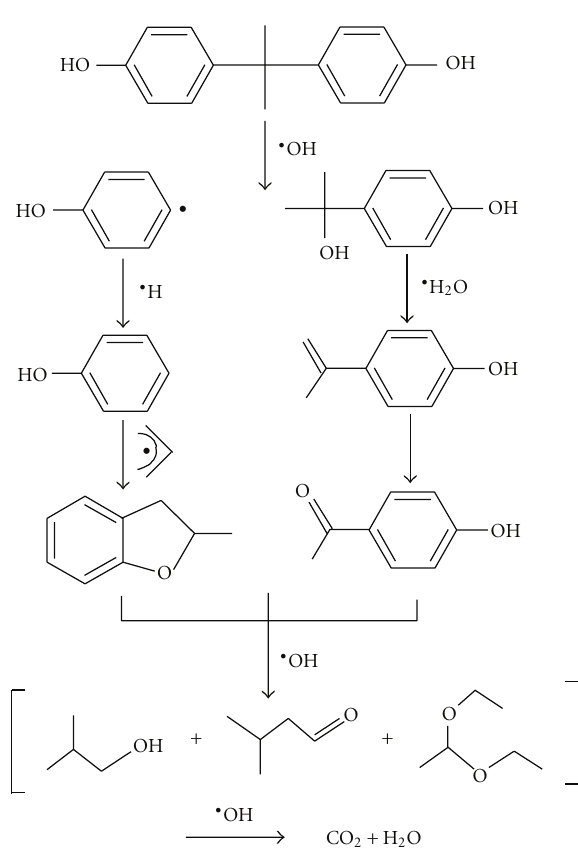
Figure 8: Photocatalytic degradation scheme for BPA [88].